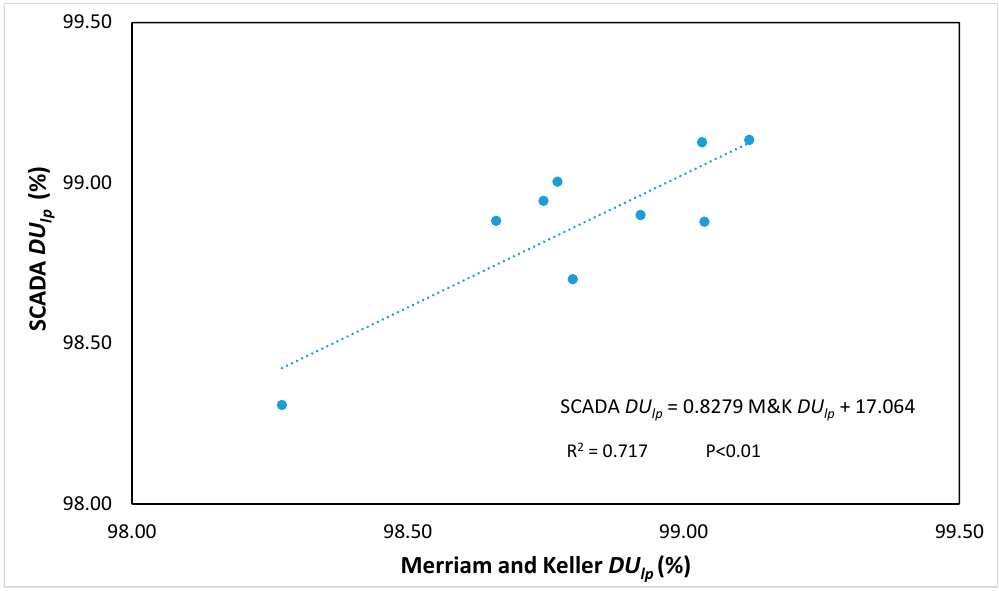
Figure 4. Relationship between observed DU lp (%) following Merriam and Keller procedure and DU lp (%) recorded by the SCADA system at the beginning, after 500 h, and 1000 h of the experiment.